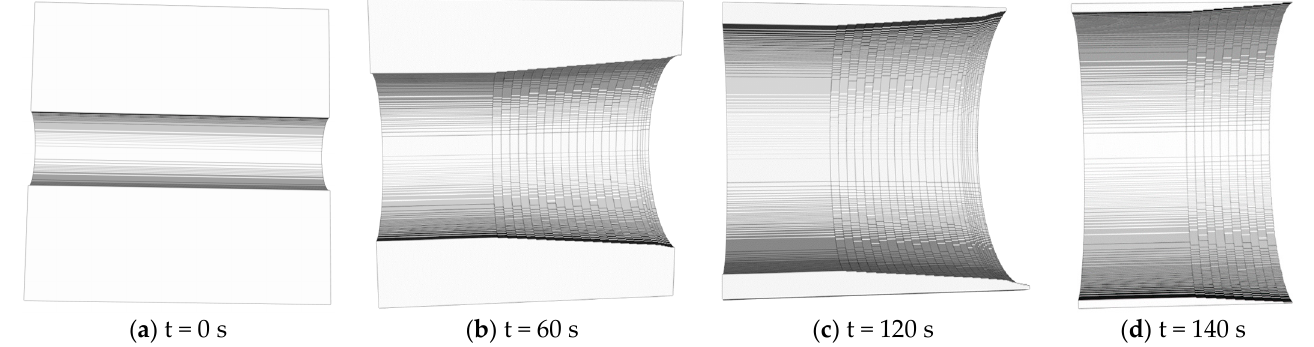
Figure 10. Burning process of tube grain under erosive burning.